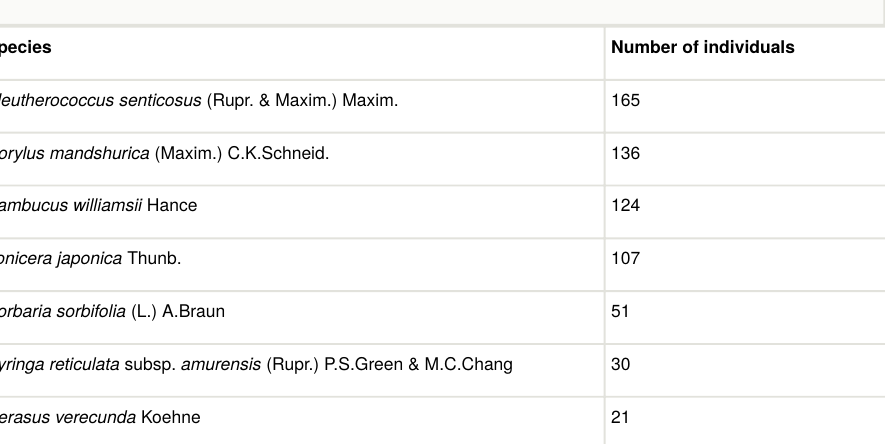
Table 8. The number of individuals in each species of shrub in Liangshui National Natural